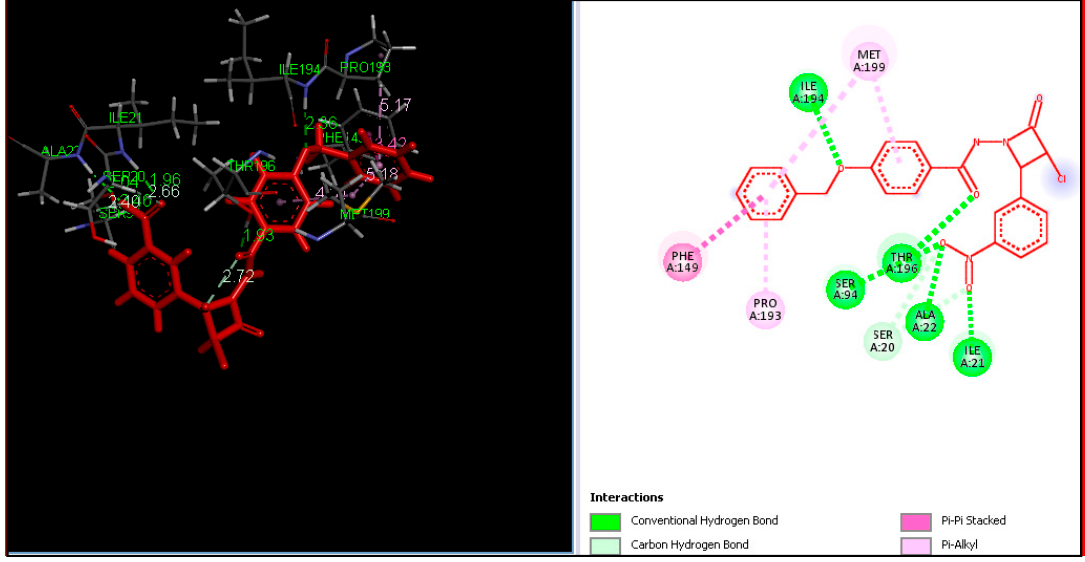
Figure 4. Binding Pose and molecular interactions of 6e into the active site of InhA.